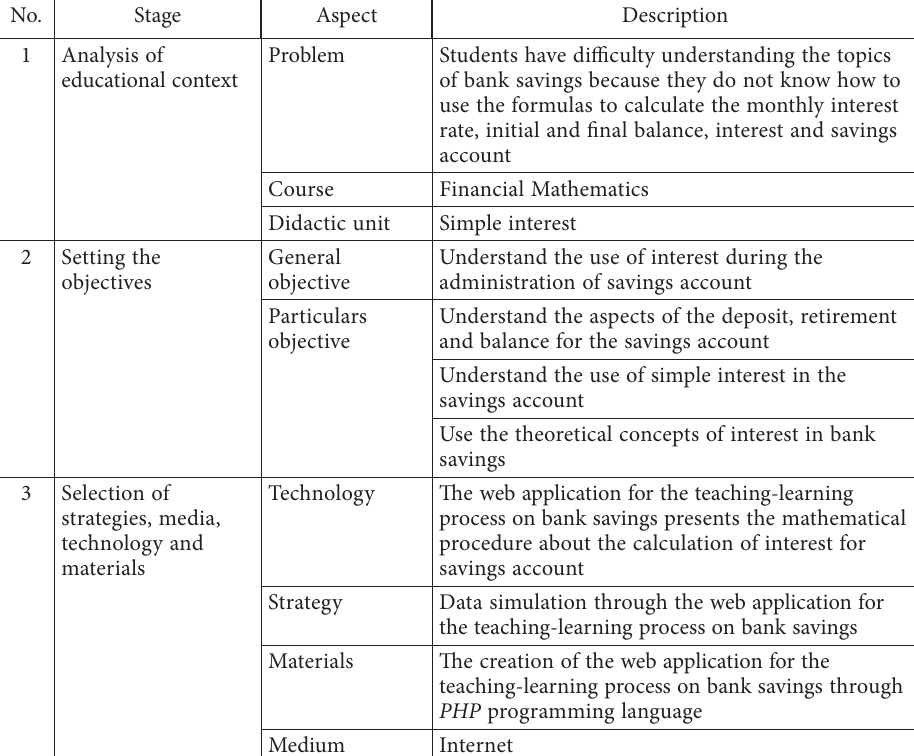
Table 1. ASSURE model (source: created by authors)